Question: Describe this figure in one sentence.
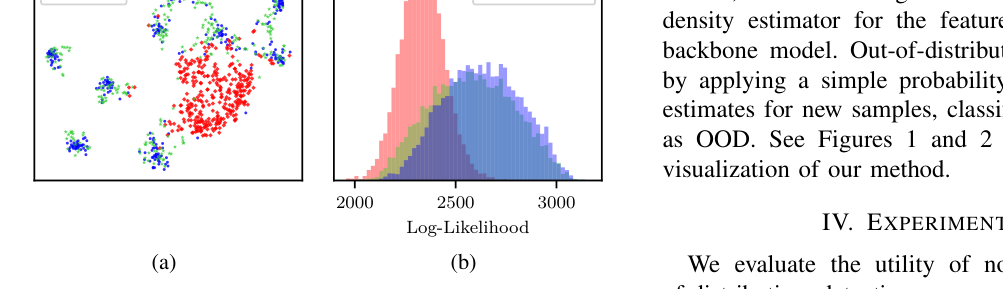
Answer: (a) A t-SNE visualization of the feature space of a ResNet18 backbone model comparing ID data (CIFAR- 10), OOD data (SVHN), and flow generated feature vectors. Clearly visible are 10 clusters corresponding to the 10 classes of CIFAR-10, and the coincidence between the ID data and the flow generated data points. (b) A histogram of the log-likelihood of ID features vs. OOD features under the normalizing flow model. Better separability of these distributions leads to higher AUROC for OOD detection.